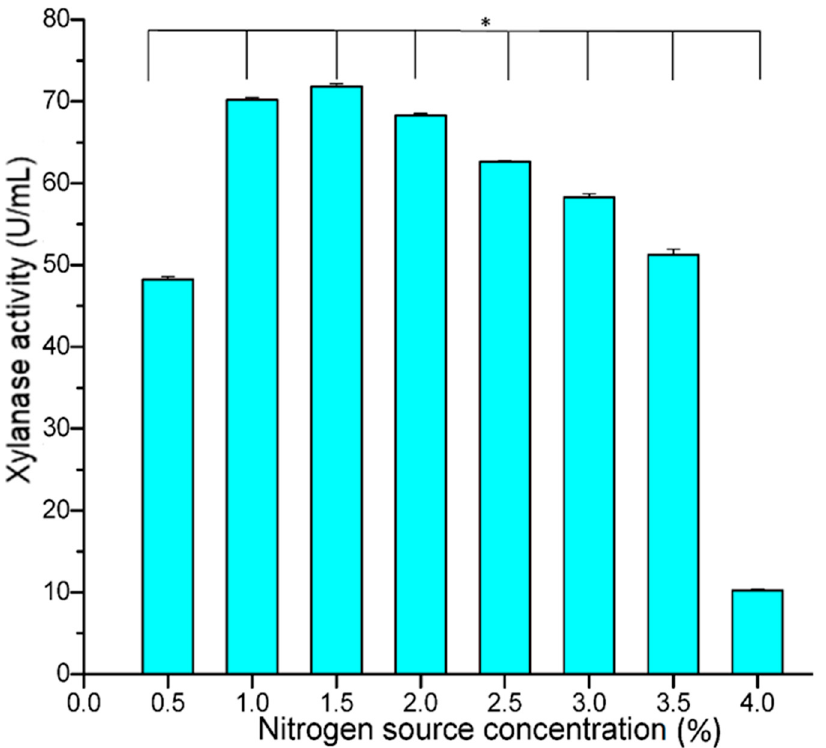
Figure 6. Effect of nitrogen source concentration on the xylanase production by B. safensis XPS7 (Medium: M5; temp.: 30 °C; time: 24 h; pH: 8; inoculum: 4%). All the experiments were performed in triplicate. Bars display mean ± SD and statistical analysis was performed using a one-way ANOVA with a Tukey post hoc test, with p < 0.01 *.